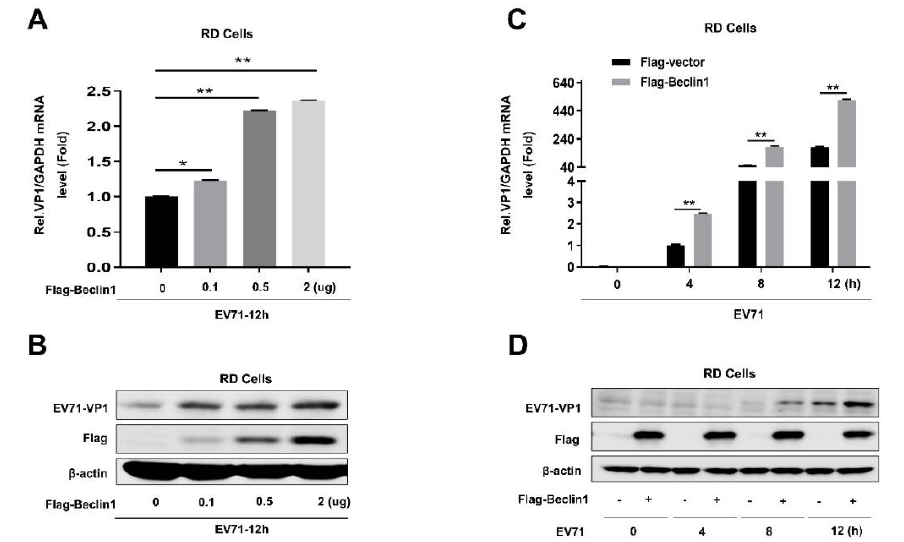
Figure 2. Beclin1 promotes EV71 replication in RD cells. ( A and B ) RD cells were transfected with Flag-vector or Flag-Beclin1 at the indicated concentrations for 24 h and infected with EV71 (MOI = 1) for 12 h. The RNA and protein levels of EV71 VP1 were detected by Real-time PCR with GAPDH as an internal control ( A ) and Western blot ( B ), respectively. ( C and D ) RD cells were transfected with Flag-vector or Flag-Beclin1 for 24 h and then infected with EV71 (MOI = 1) at the indicated times. The RNA and protein levels of EV71-VP1 were detected by Real-time PCR with GAPDH as an internal control ( C ) and Western blot ( D ), respectively. Graph expressed as mean ± SD, ns, not-significant; *, p < 0.05; **, p < 0.01.